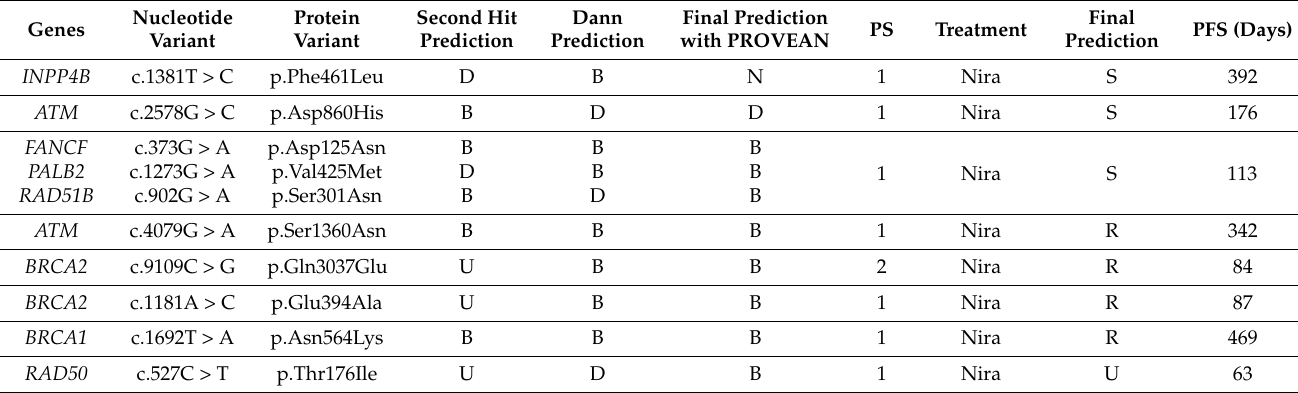
Table 5. Prediction of VUS pathogenicity in a new cohort of ovary